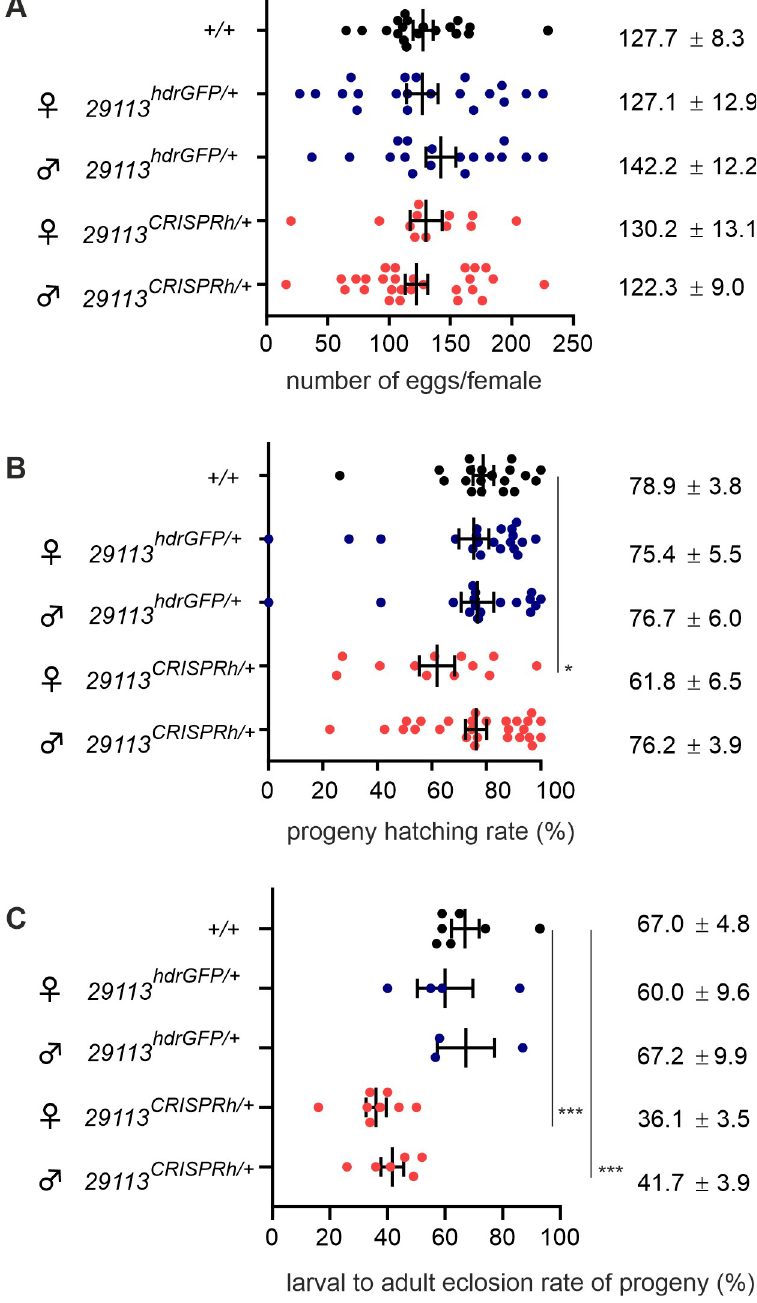
Fig 3. Phenotypic assessment of 29113 CRISPRh/+ individuals crossed with wild-type. (A) Scatter plots displaying number of eggs laid by single females in crosses of 29113 CRISPRh /+ mosquitoes with wild-type individuals. Data were analyzed by quasi-Poisson GLM model. No significant differences were found between the wild-type and transgenic strains. (B) The hatching rate of these crosses is also displayed. Data were analyzed by quasi-binomial. No significant differences were found. (C) Larval to adult eclosion rate. Data were analyzed by a random effect binomial GLM model. � p < 0.05, �� p < 0.01, ��� p < 0.001.